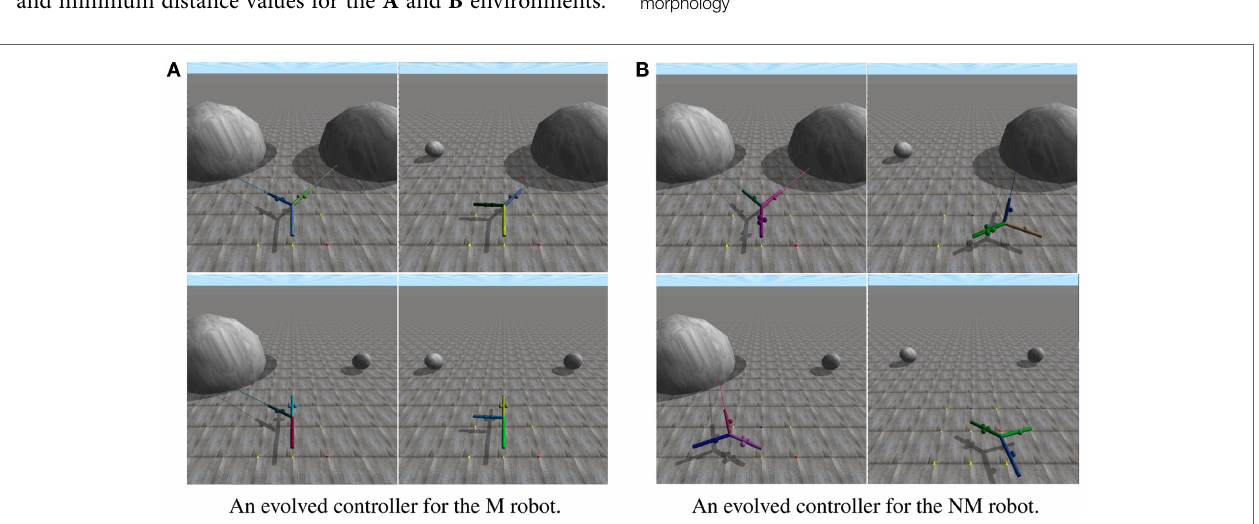
Fr ontiers in Robotics and AI |